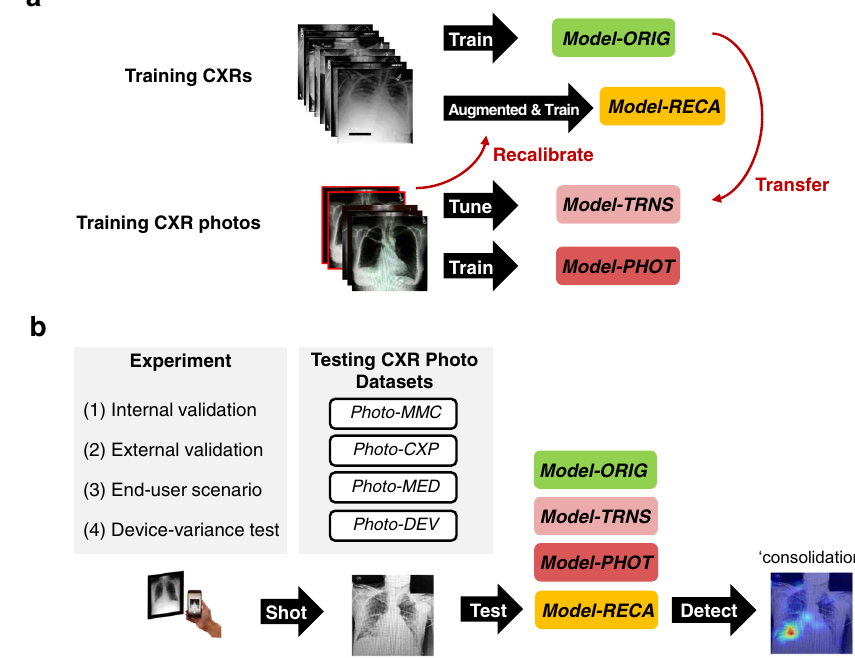
Fig. 1 Overview of the proposed method. a The uncalibrated model ( Model-ORIG ) was trained on the original CXR images. The transfer learning-based model ( Model-TRNS ) was transferred from the uncalibrated model and fi ne-tuned by real photographs. The photograph-based model ( Model-PHOT ) was trained by the real smartphone-captured photographs. The recalibrated model ( Model-RECA ) was recalibrated from Model-ORIG by using augmented CXR images. b Model-ORIG , Model-TRNS , Model-PHOT , and Model-RECA were tested on four CXR photograph datasets ( Photo-MMC , Photo-CXP , Photo-MED , and Photo-DEV ) in four experiments. The performance metrics across 14 labels were calculated. Gradient-weighted Class Activation Mapping was employed for diagnostic focus visualization of